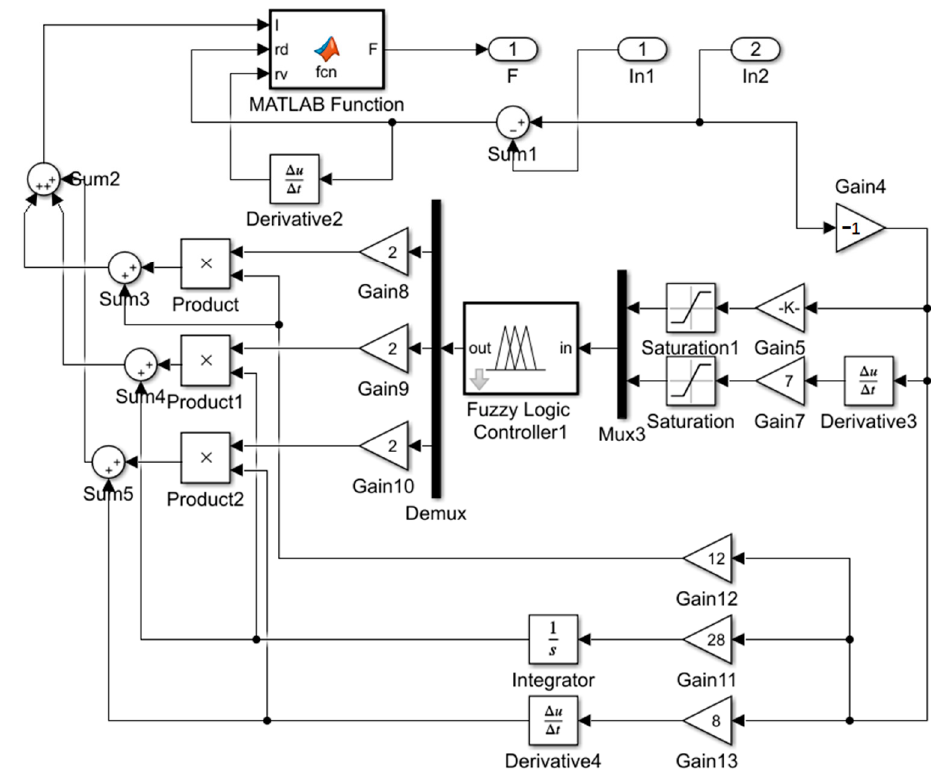
Figure 14. Fuzzy PID controller block diagram. Table 2. Response of the vibration isolators under vibration signals.